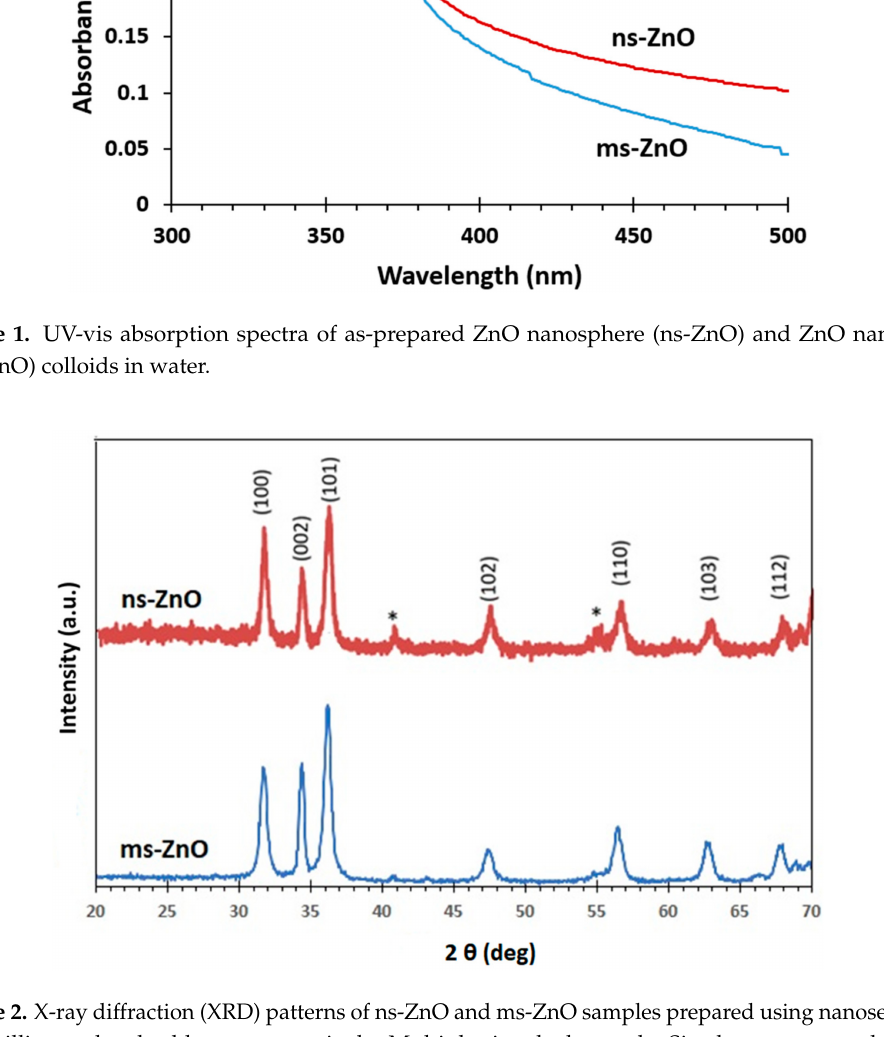
Figure 2. X-ray diffraction (XRD) patterns of ns-ZnO and ms-ZnO samples prepared using nanosecond- and millisecond-pulsed lasers, respectively. Multiple signals due to the Si substrate are marked by asterisks. All signals in both patterns were indexed as hexagonal